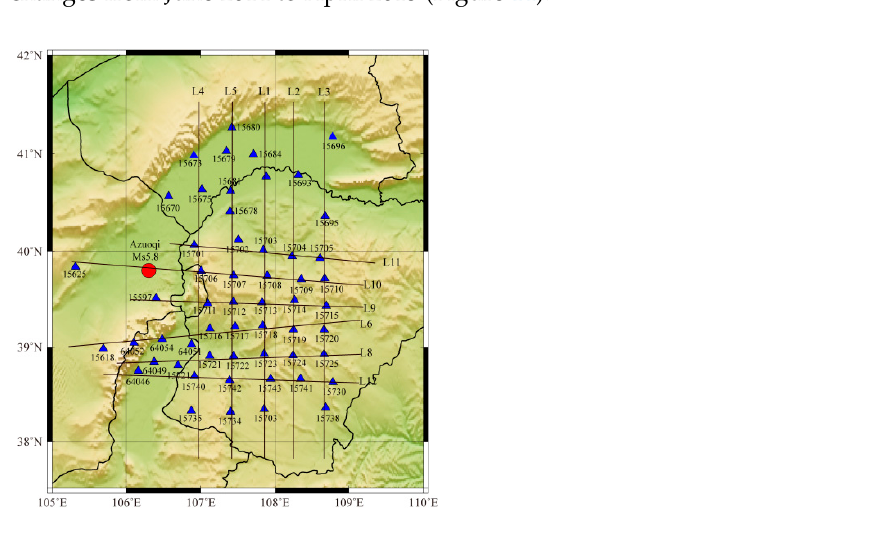
Figure 9. Seismic array near the Ms5.8 earthquake in Azuoqi, Inner Mongolia, on 15 April 2015.